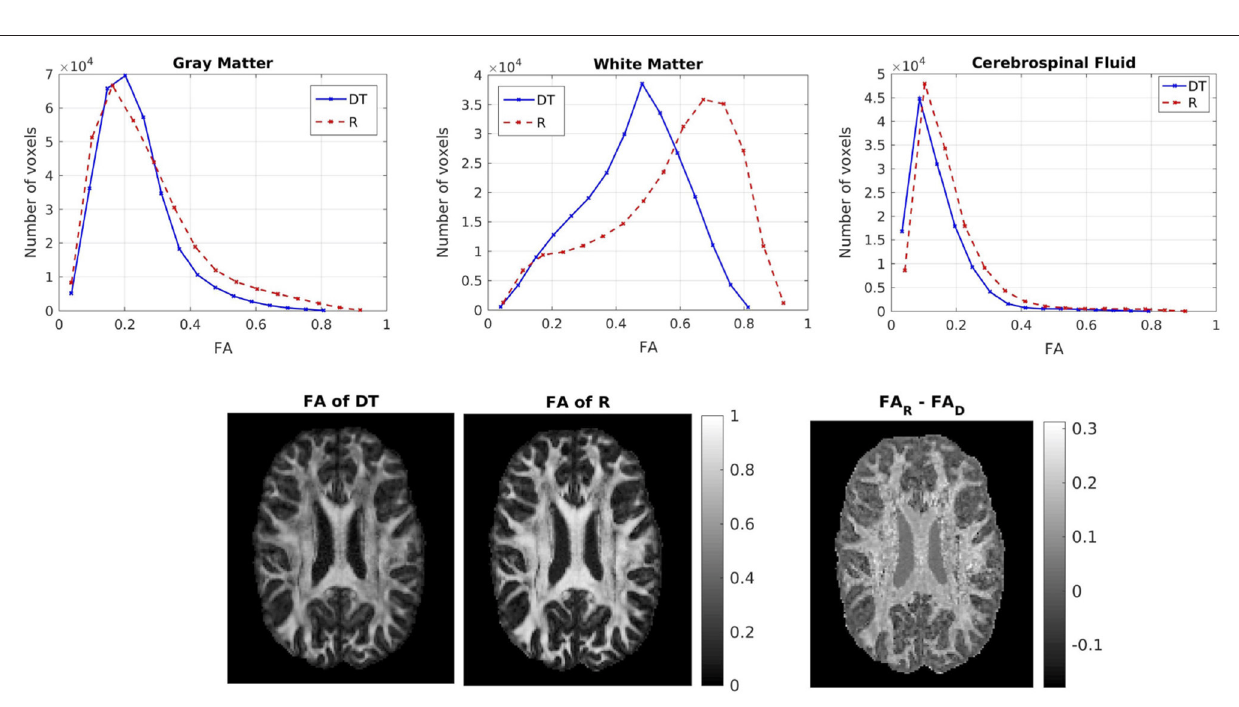
different brain slices. The ratio is around the value of 1,